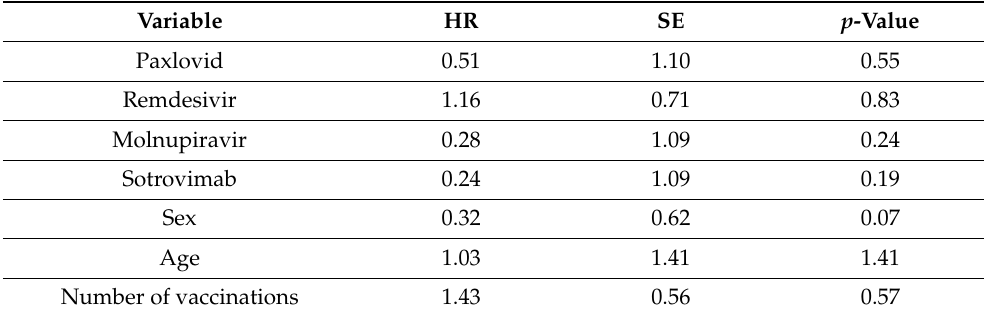
Table 3. Multivariate Cox regression for 28-day hospital admission considering the impact of each